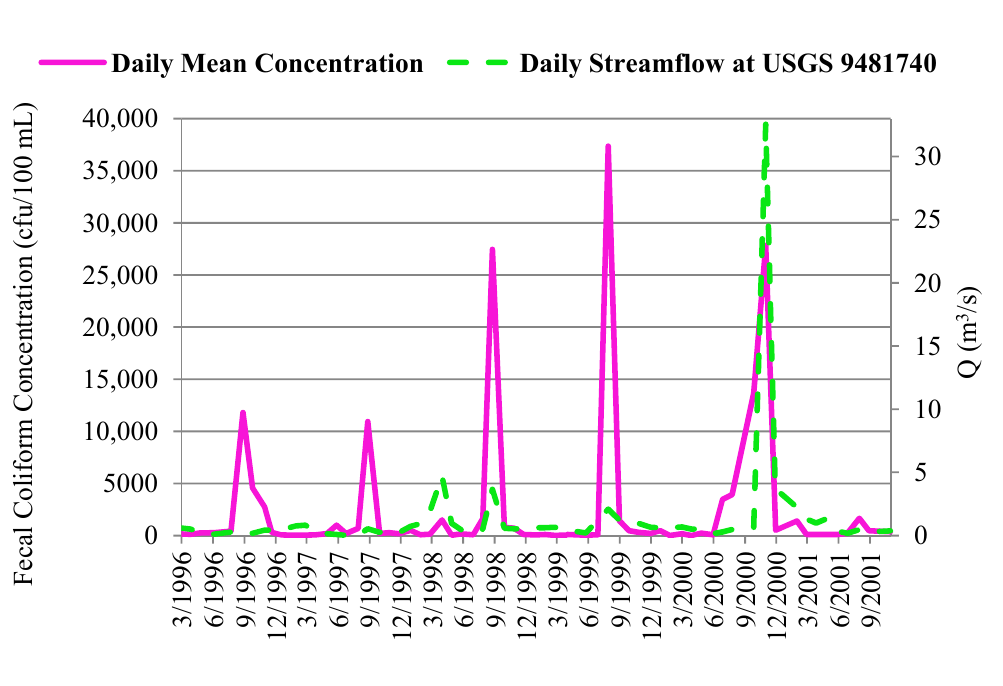
Figure 2. In-stream fecal coliform concentrations along the Upper Santa Cruz River compared to average daily streamflow at USGS station 9481740 from March 1996 to August 2001. The Arizona WQ standard for fecal coliforms is 800 cfu/100 mL for a single sample